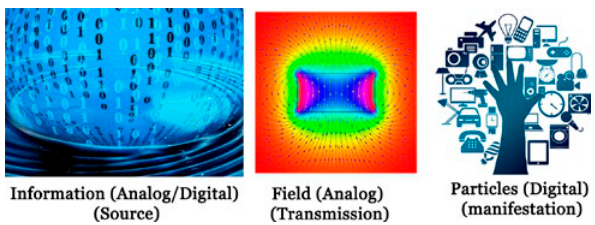
Figure 5. The three fundamental modes of perception of conscious- ness gives rise to the three basic models of reality: viewed as infor- mation at a primordial source level, viewed as fields during propa- gation and viewed as particles upon Manifestation as